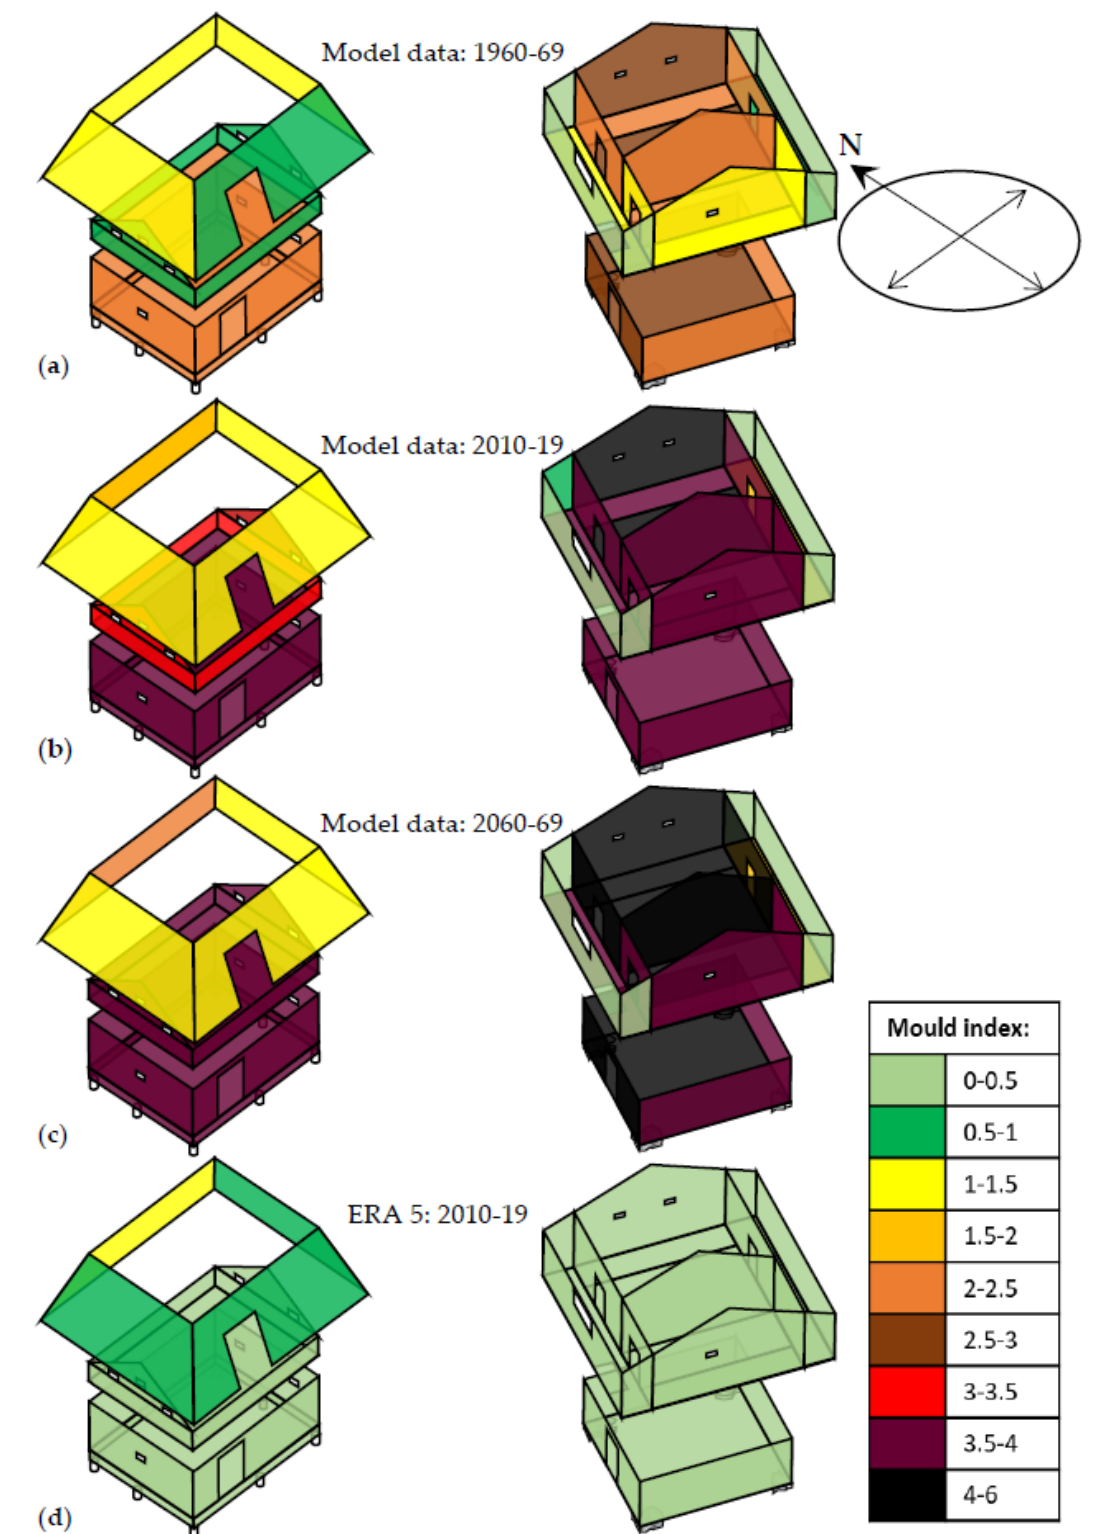
Figure 14. Average values of annually maximum mold indices under ( a ) past, ( b ) current, and ( d ) future climate conditions, considering climate data from MPI-ESM-LR_REMO2015 model. ( d ) Respective results for the current conditions by considering climate data from the ERA5 reanalysis. The results refer to the interior surfaces of the building components, with the exception of the coating of the Fadum storehouse where the exterior side is taken into account.